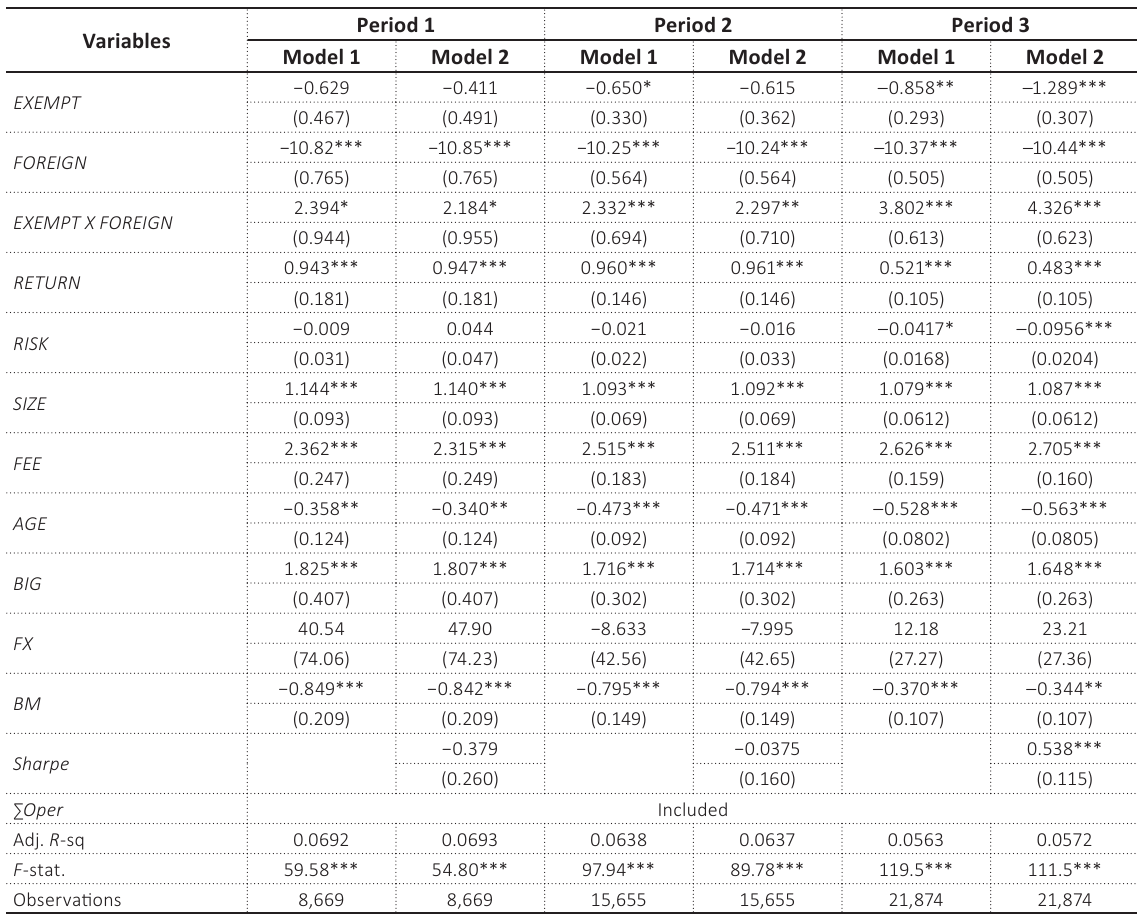
Table 6. Regression results: RSTA 2007